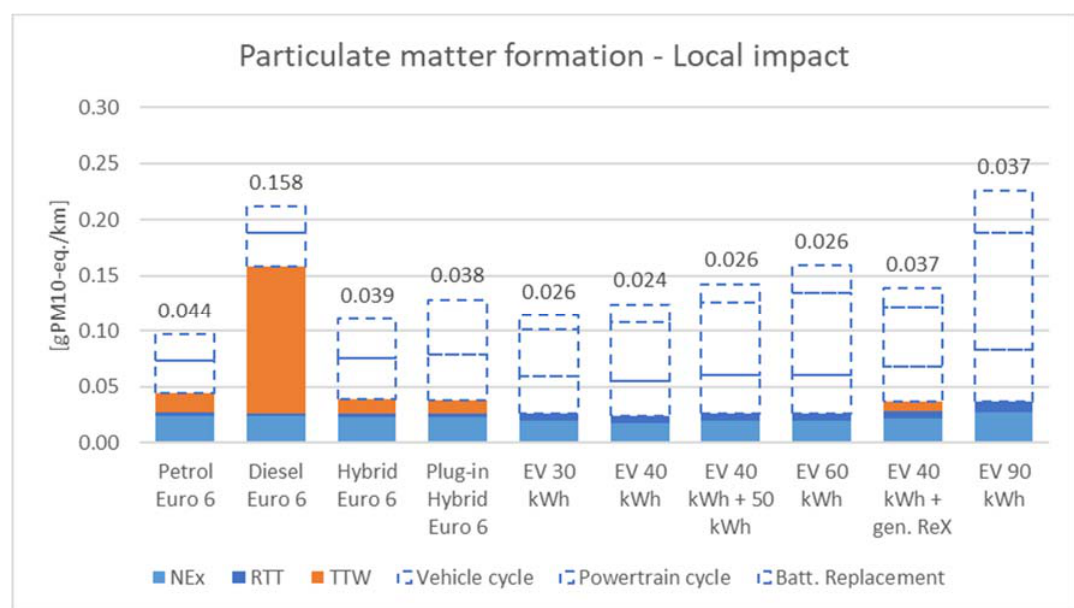
Figure 8. Impact per kilometer on particulate matter formation during use of the vehicle (including the refinery-to-tank (RTT) emissions upstream). Tank-to-wheel (TTW) emissions are further disaggregated to exhaust TTW and non-exhaust PMF (NEx).